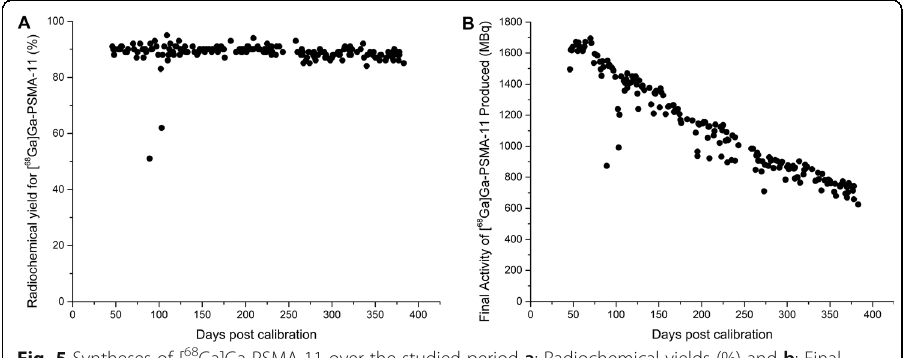
Fig. 5 Syntheses of [ 68 Ga]Ga-PSMA-11 over the studied period a : Radiochemical yields (%) and b : Final product activity